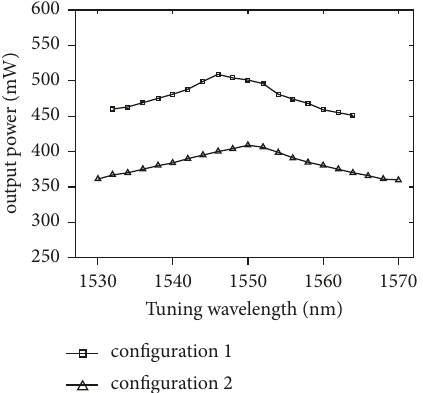
Figure 9: The slope efficiency when the tuning wavelength is 1546nm for configuration 1 and 1550nm for configuration 2.